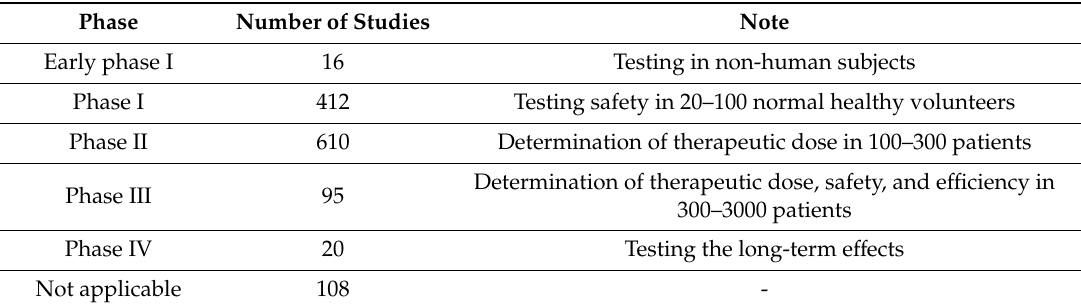
Table 1. The number of bone marrow stem cells trials classified by the phase